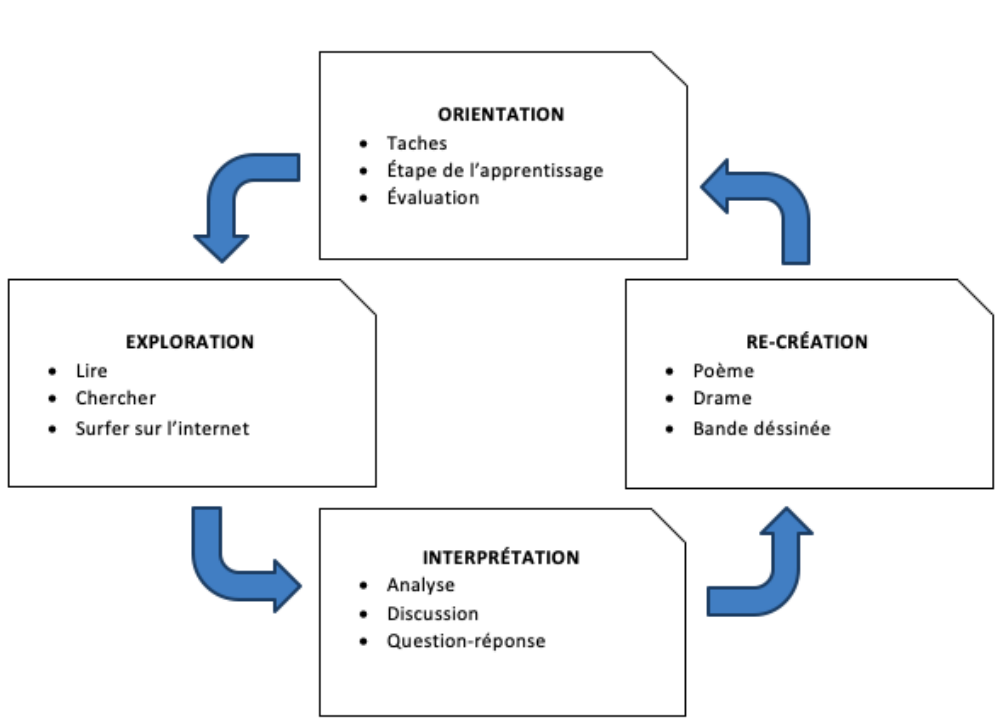
Figure 1 Le model d’enseignement créatif et